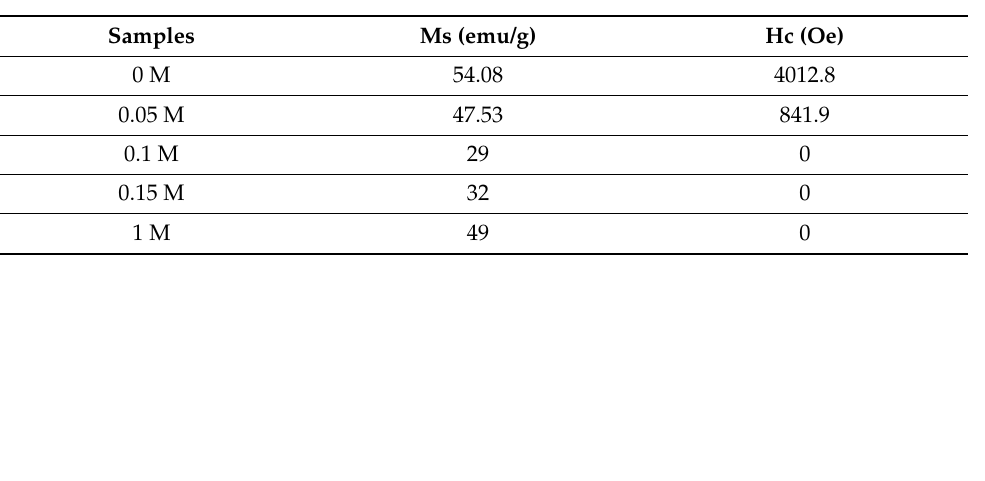
Table 3. Saturation magnetization (M S ) and coercivity (H C ) of samples prepared with different oleic acid